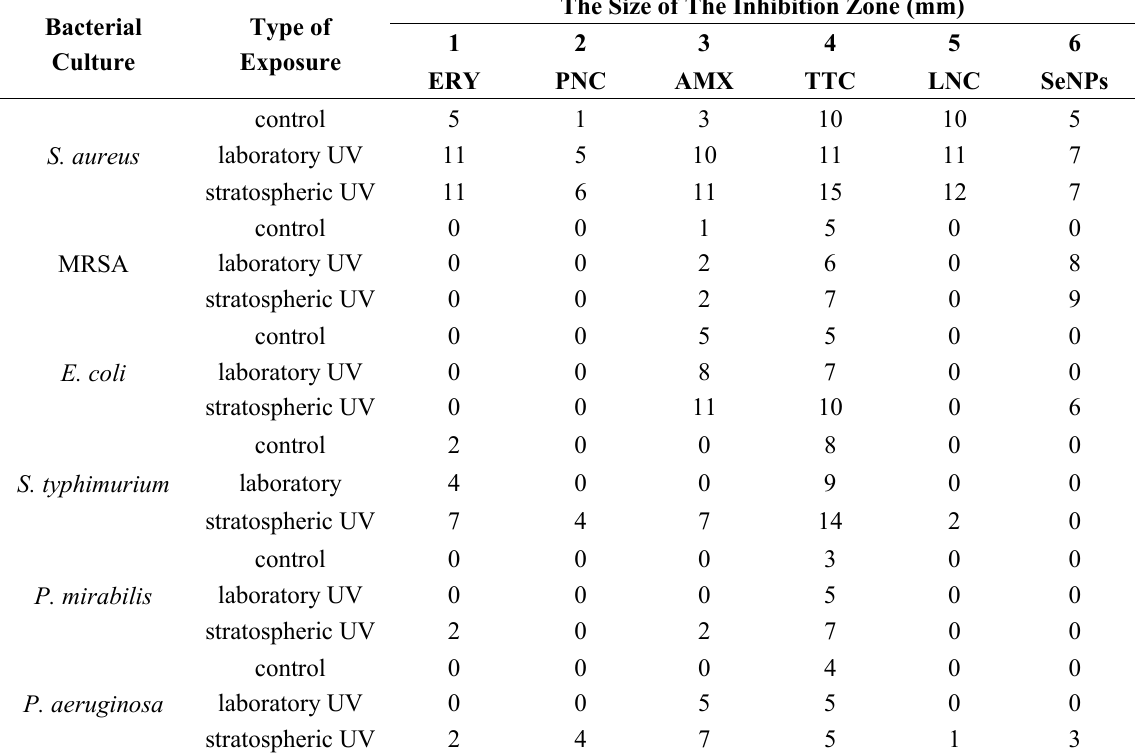
Table 2. Resistance of bacterial cultures to antibiotic drugs or semimetal nanoparticles (1, erythromycin; 2, penicillin; 3, amoxicillin; 4, tetracycline; 5, lincomycin; and 6, selenium nanoparticles) without UV exposure, after exposure to laboratory UV and after exposure to stratospheric UV radiation. Bacterial cultures were exposed to commercial antibiotic drugs in Petri dishes for 24 hours in an incubator at 37 °C. The sizes of the resulting inhibition zones in millimeters indicate the level of the bacterial strains’ resistance to antibiotics. The lower the zone formation, the strain is described as more